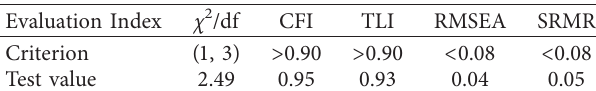
Table 6: Test results of goodness of